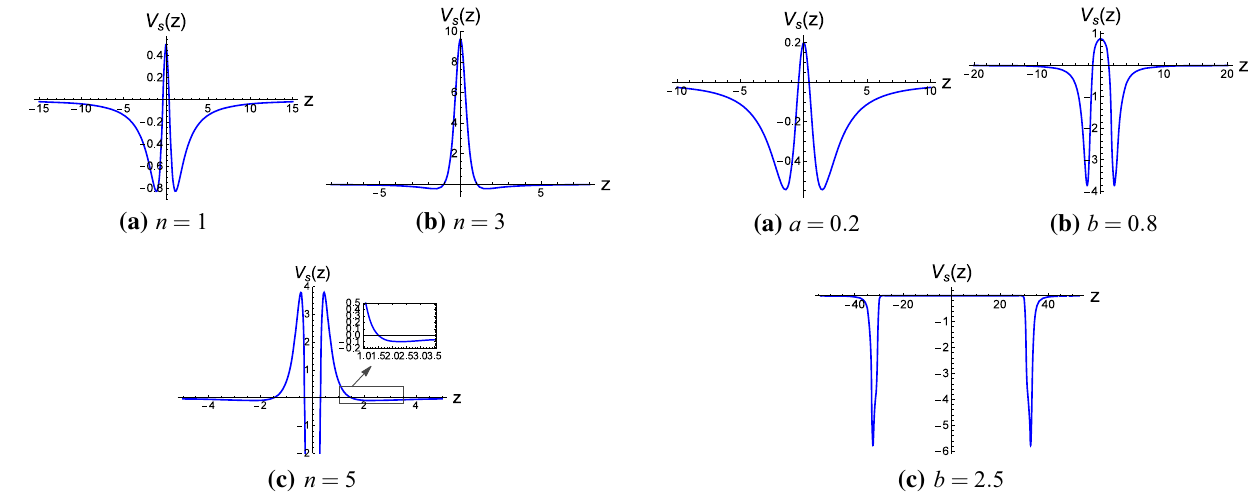
Fig. 6 a n = 1, b n = 3, c n = 5. The effective potential V s ( z ) for model 1. The parameters are set k = 1, v = 1 and n = 1 in a , n = 3 in b , n = 5 in c